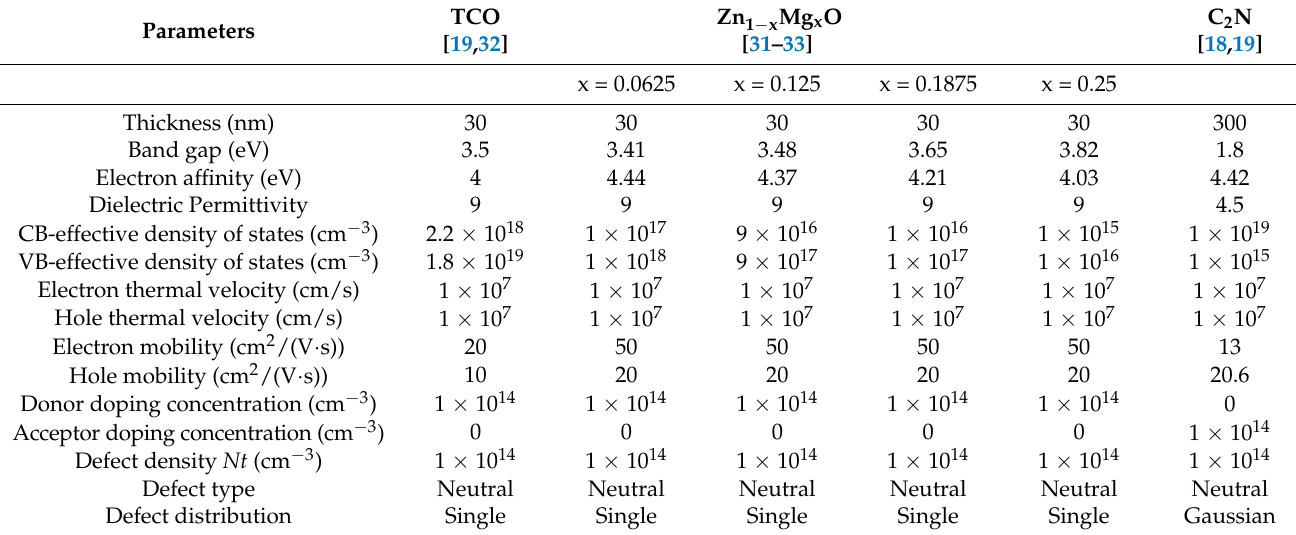
Table 1. Initial key input parameters for the SCAPS-1D